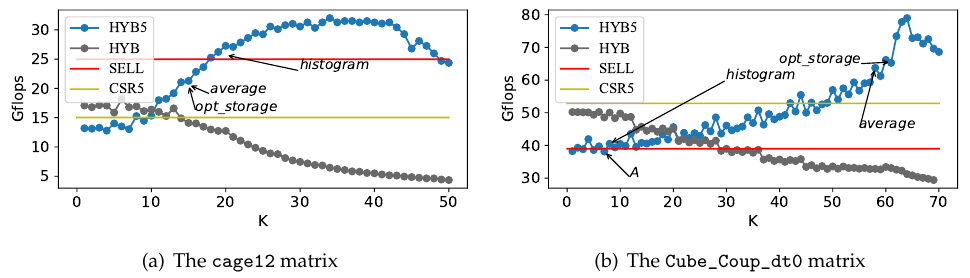
Figure 3. How the performance of HYB and HYB5 changes as the partitioning threshold K changes on two sparse matrices ( a , b